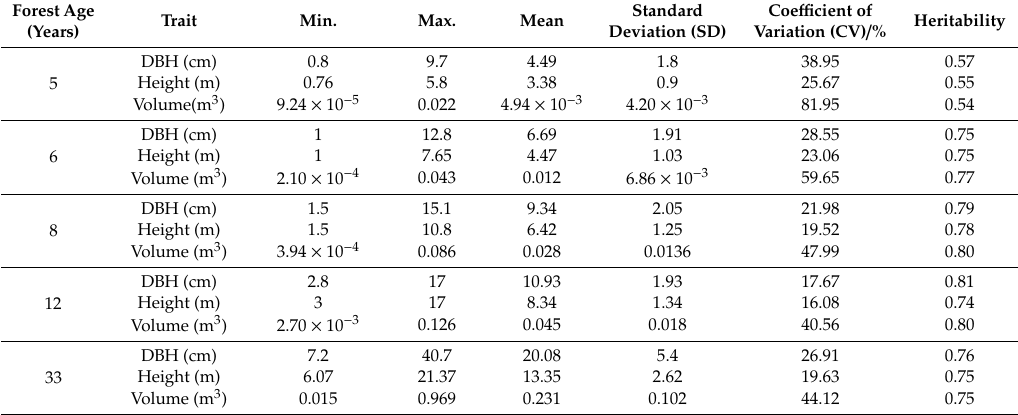
Table 2. Parameters of the growth variation of Chinese fir obtained from theprovenance test for di ff erent forest